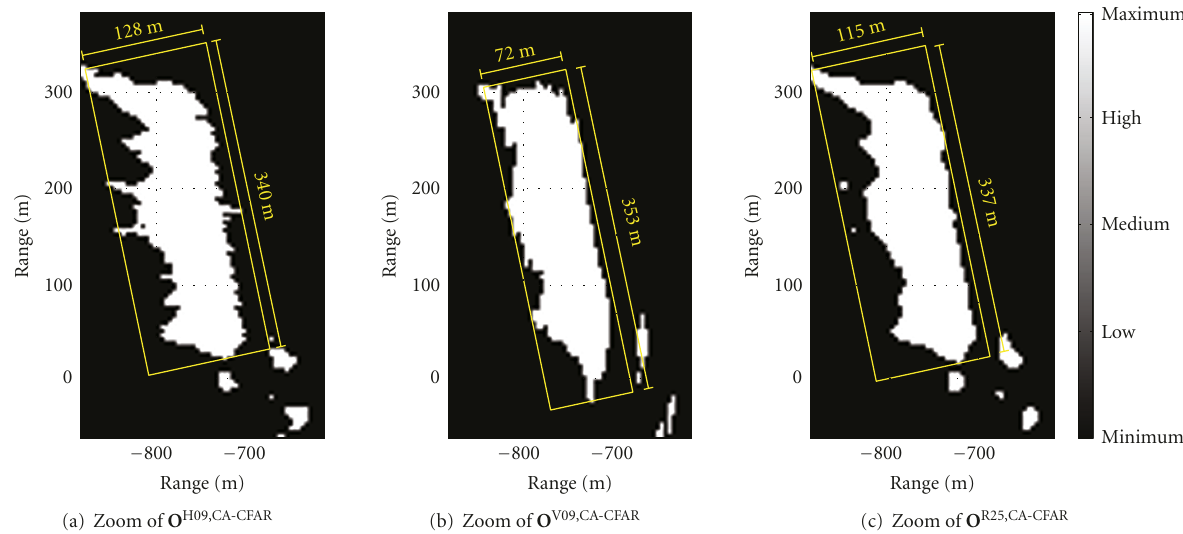
Figure 12: Zoom of the Images Processed by the CA-CFAR Detection System Using its Best H, V, and R Integration Modes.